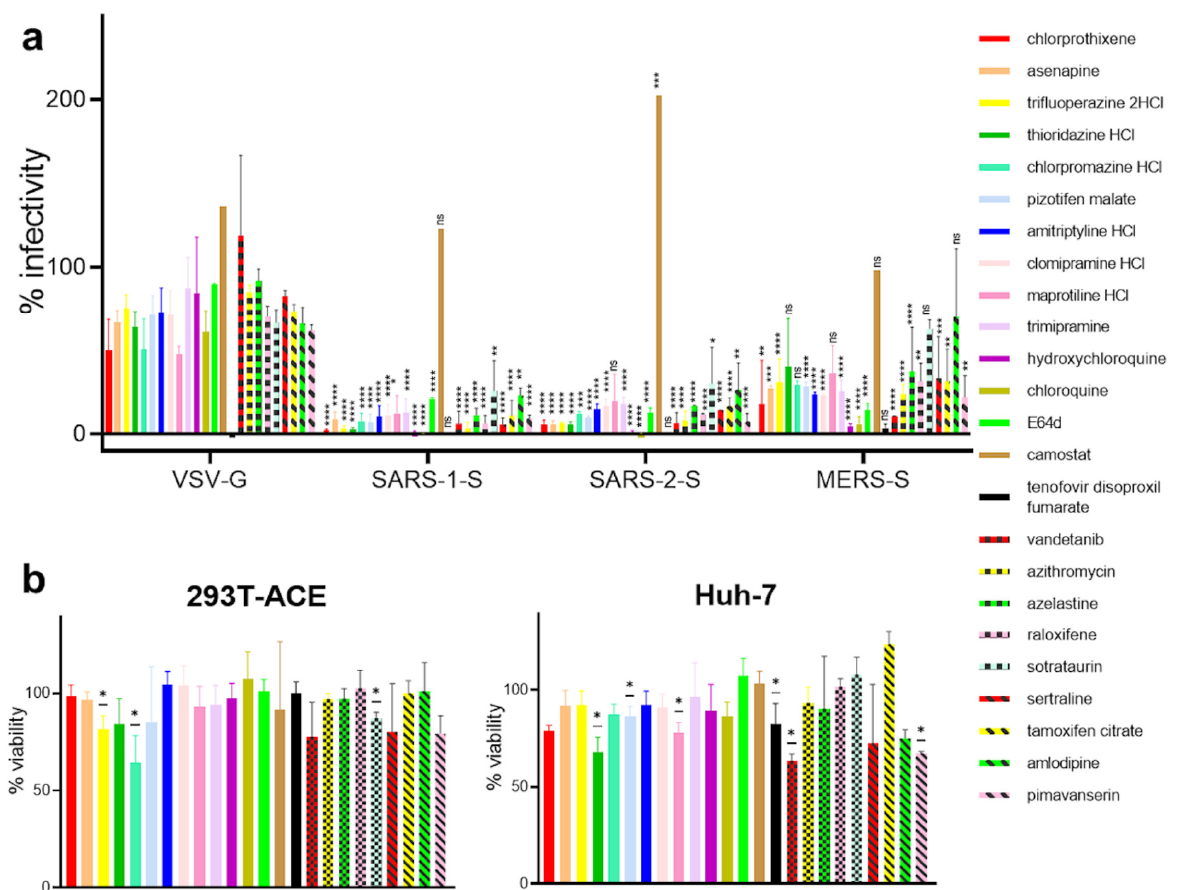
Figure 4. Kite-shaped molecules specifically inhibit coronavirus infection. Mouse leukemia virus pseudotyped with glycoprotein from vesicular stomatitis virus (VSV-G) and spike protein (S) from severe acute respiratory syndrome coronavirus (SARS-1-S), SARS-CoV-2 (SARS-2-S), and Middle East respiratory syndrome coronavirus (MERS-S), was used to infect 293T-ACE2 cells, in a 96-well plate for 48 h in the presence of the drug, as indicated, with 1 h pre-treatment. ( a ) Infectivity was measured as luciferase activity and expressed as % infectivity versus infected, solvent control. Data are presented as mean ± SD of two-three repeats. Statistically significant differences compared with VSV-G pseudovirus are analysed by 2-way ANOVA and are represented by * p < 0.05, ** p < 0.01, *** p < 0.001, and **** p < 0.0001. ns = non-significant. The differences of % infectivity between SARS-CoV-1-S or SARS-CoV-2-S with MERS-CoV-S pseudoviruses are significant in trifluoperazine, thioridazine, sotrastaurin, and amlodipine treatments (not shown). ( b ) Viability was measured by XTT assays in uninfected samples and expressed as % viability versus solvent control. Data are presented as mean ± SD of two-four repeats. Statistically significant differences are analyzed by one-sample t -test and are represented by * p < 0.05.